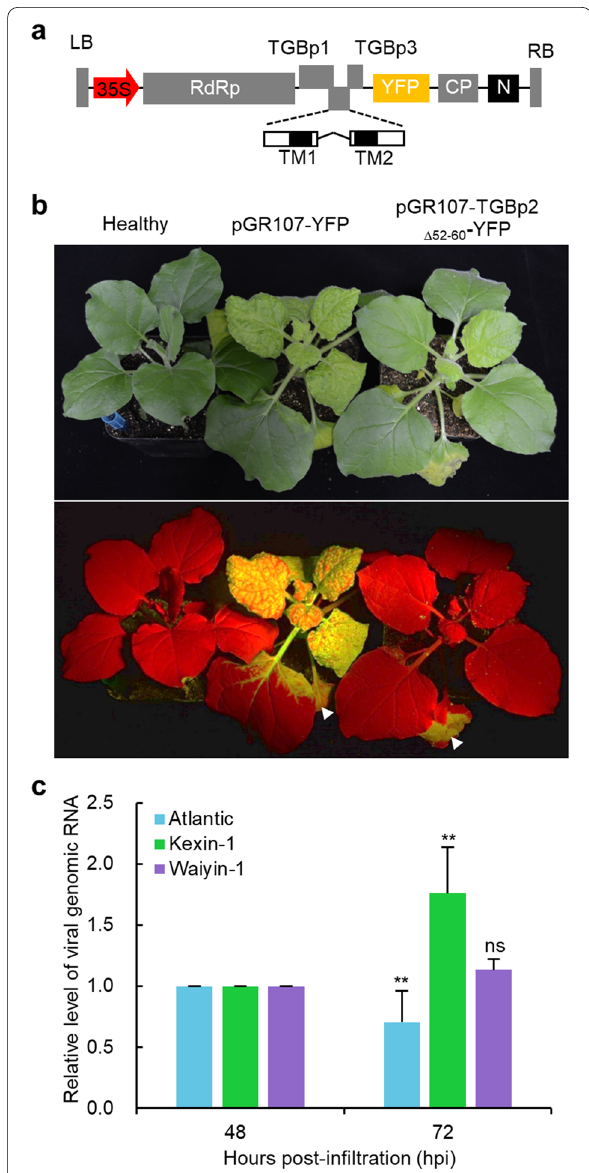
Fig. 5 The replication of PVX is inhibited in Waiyin-1. a Diagram illustration of pGR107-TGBp2 ∆52–60 -YFP. TM1 and TM2 are the transmembrane motif 1 and transmembrane motif 2 of TGBp2, respectively; other labels are the same as in Fig. 2a. b Symptoms of N. benthamiana seedlings infected with pGR107-TGBp2 ∆52–60 -YFP under white (upper panel) and UV light (lower panel) at 6 dpi. White triangles indicate the inoculated leaves. c RT-qPCR analysis of the replication of pGR107-TGBp2 ∆52–60 -YFP in leaves of Waiyin-1, Kexin-1 and Atlantic infected with pGR107-TGBp2 ∆52–60 -YFP. Data represent means s.d. (n 5); ** P < 0.01; ns, no significant change (two-tailed ± = Student’s